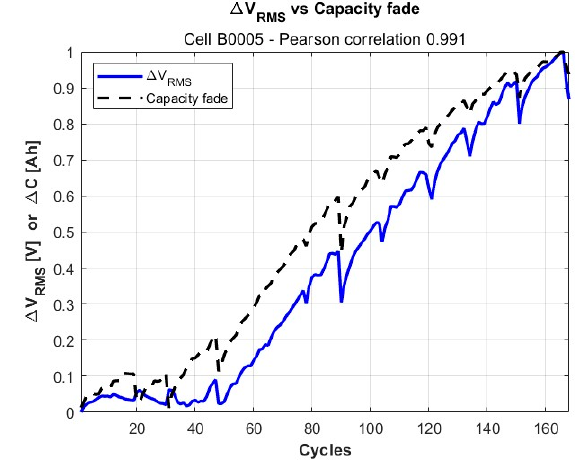
Figure 2. Evolution of the capacity fade Δ C and the proposed estimator Δ V RMS during the lifetime of cell B0005.